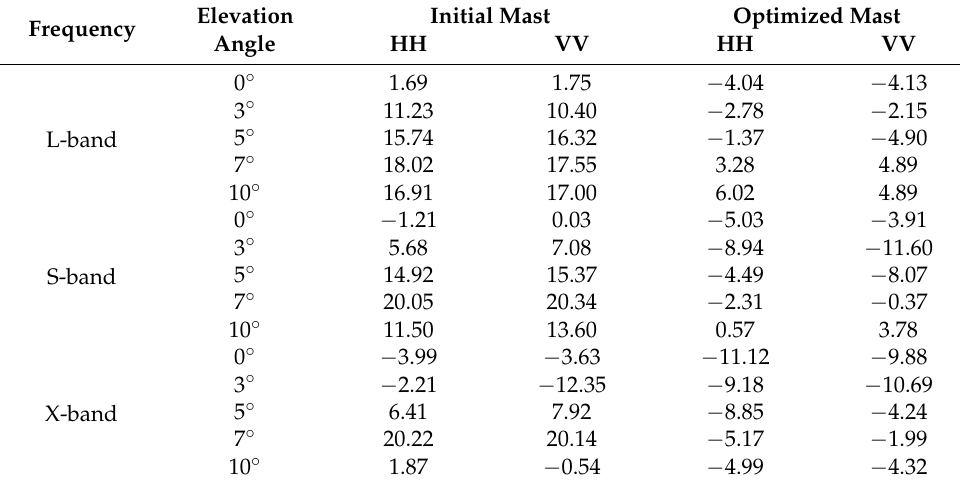
Table 1. Geometric mean of the integrated mast. (Unit: dBsm) Frequency